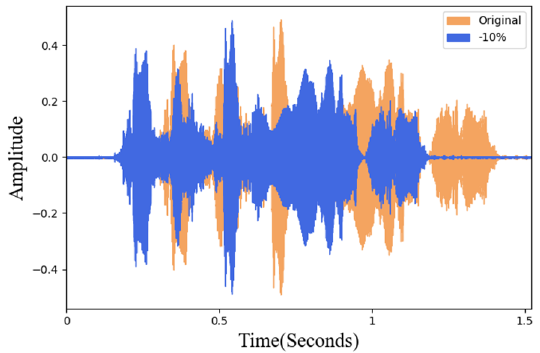
Figure 6. Waveform of frequency adjustment and original data.